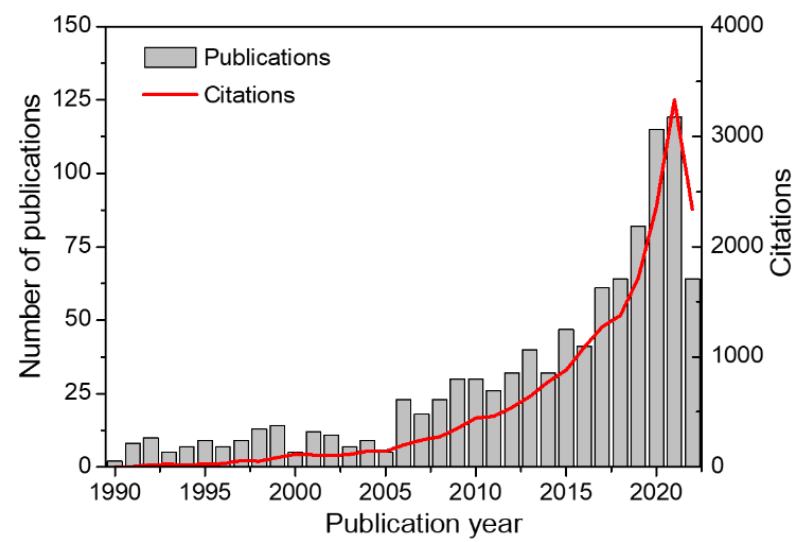
Figure 1. Number of publications and citations on SiC membranes between 1990 and 2022 (Data from Web of Science, accessed on 1 October 2022). The initial search topics were “silicon carbide” or “SiC”, which were subsequently refined for